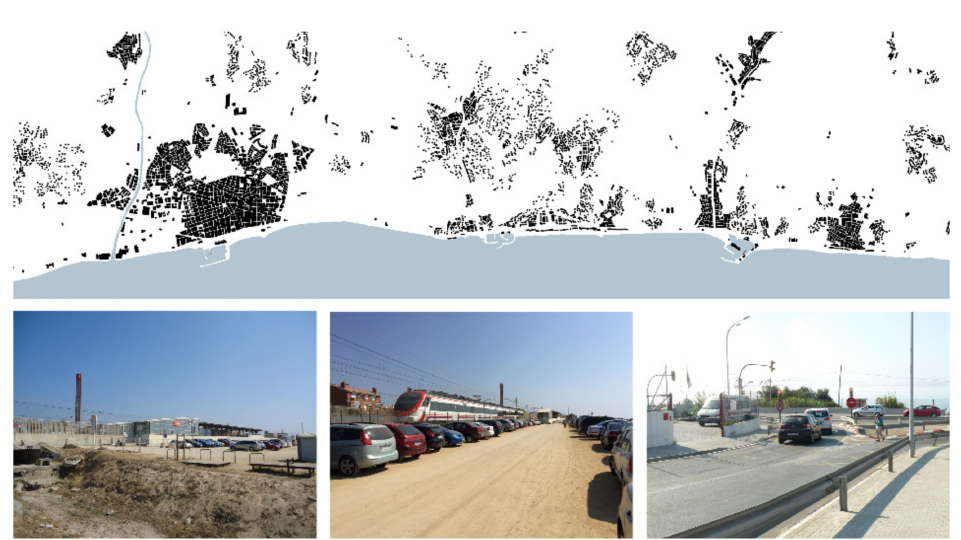
Figure 7. Urban landscape studies obsolete enclosures and buildings with multiple typologies, which become discontinuities in a general view of the littoral landscape (Source: authors’